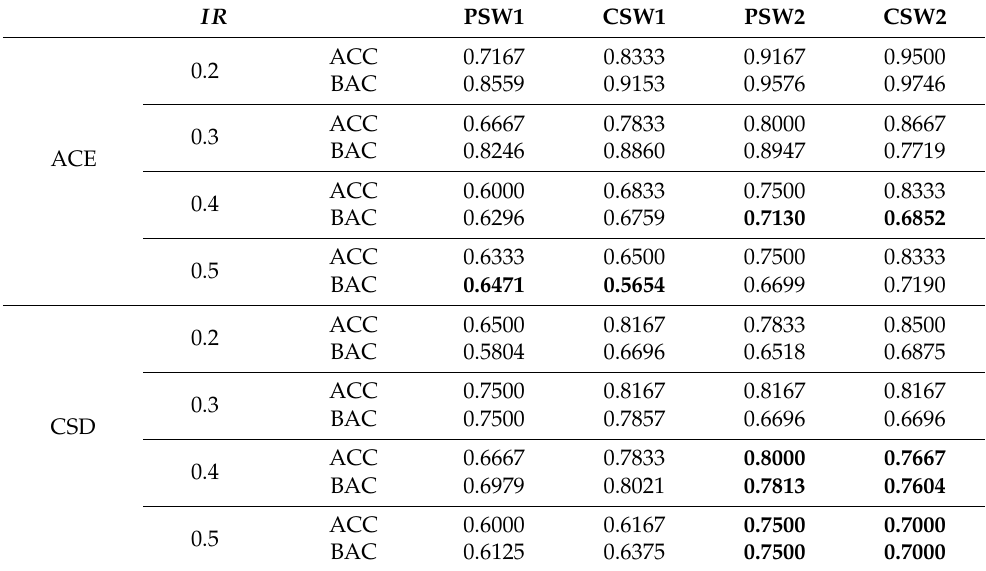
Table 4. Performance measures of classifiers based on PBDF for real